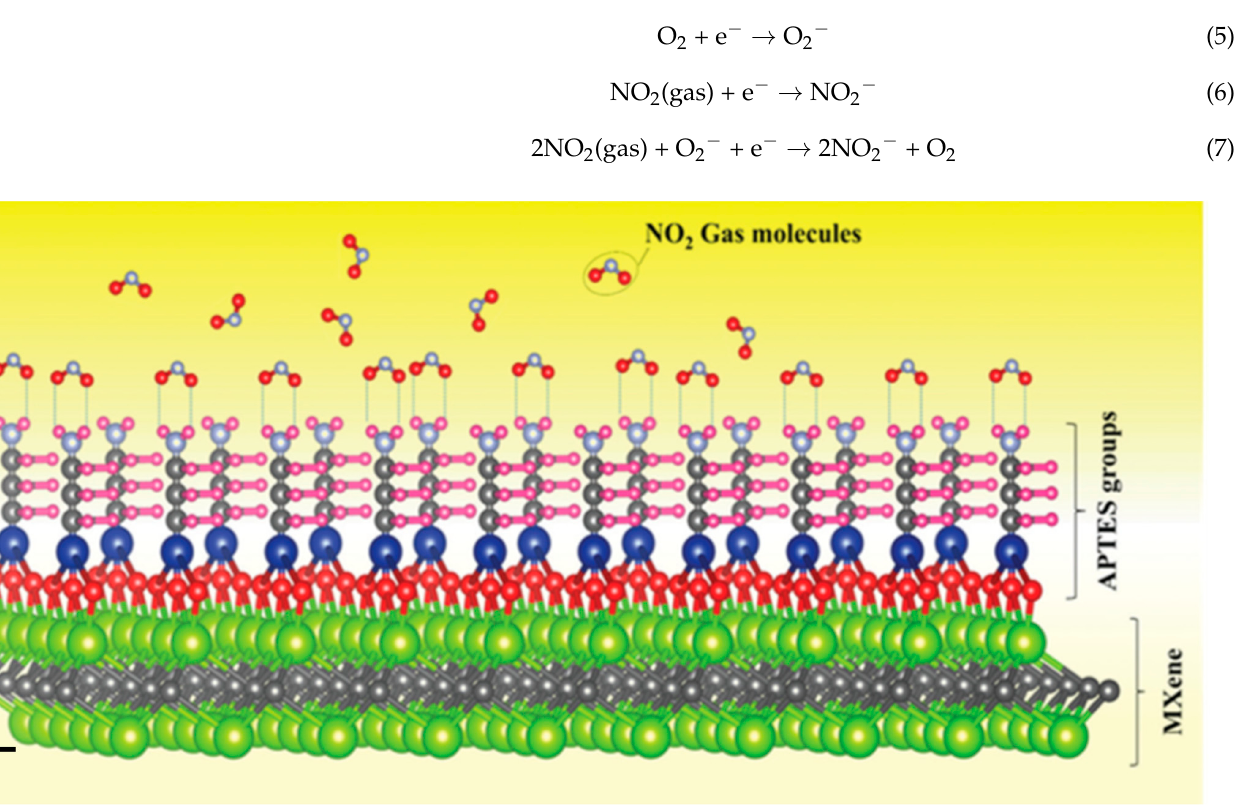
Figure 5. Sensing mechanism of Nb 2 CT x − 0.2 APTES MXene for NO 2 gas. Reprinted with permission from Ref. [70].